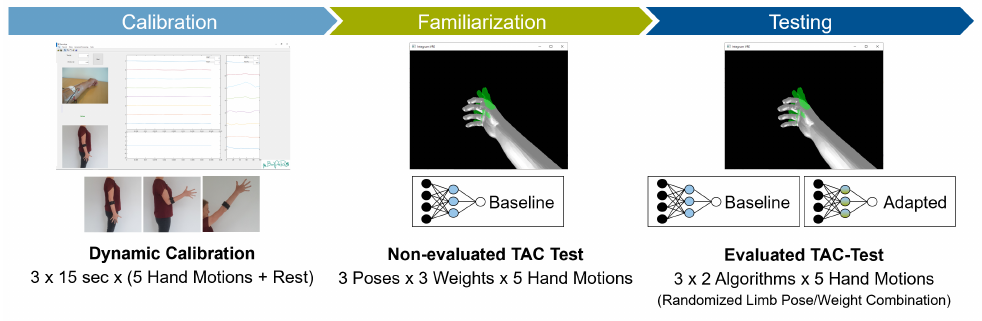
Figure 9. A summary of the experimental protocol.